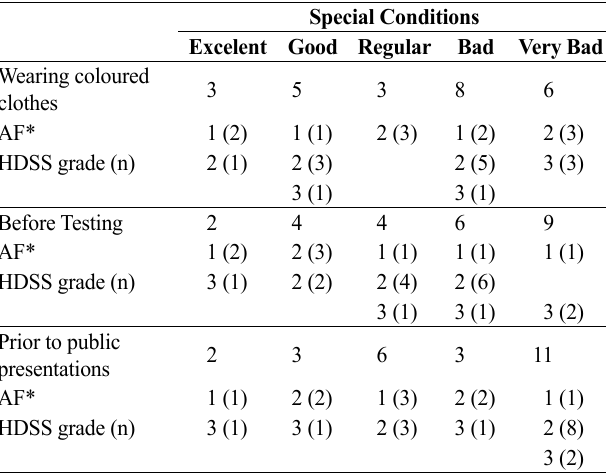
Table 7: Domain distribution Special conditions of the 25 Physical Education students with primary hyperhidrosis of a private universi- ty of Aracaju-SE, from August to November 2017, according to the classification of the quality of life questionnaire.